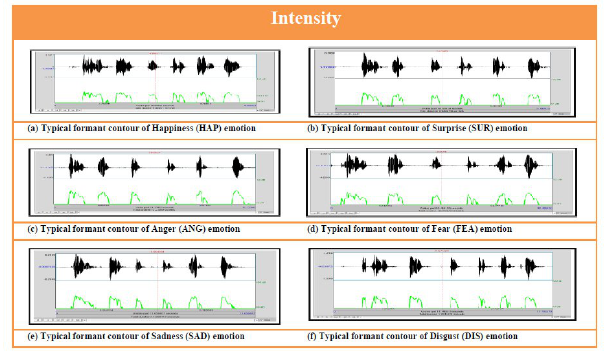
Fig. 18. American speakers typical intensity contour of basic emo-